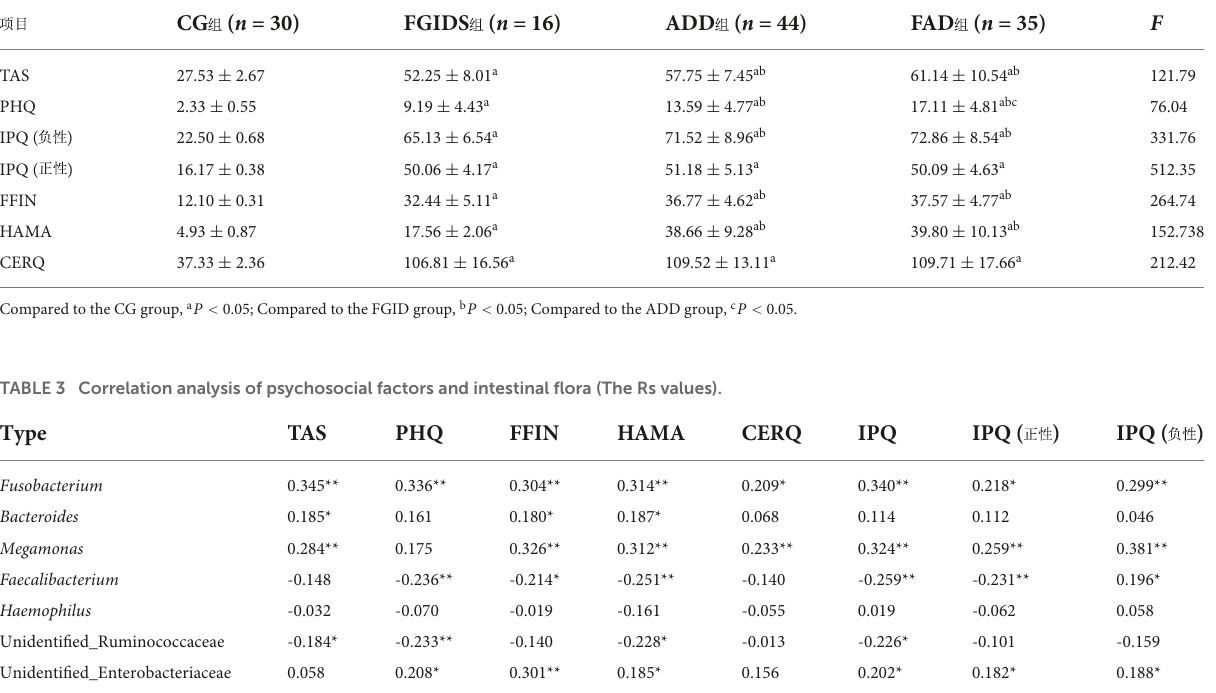
TABLE 2 Comparison of scale scores among groups ( − x ± s ).